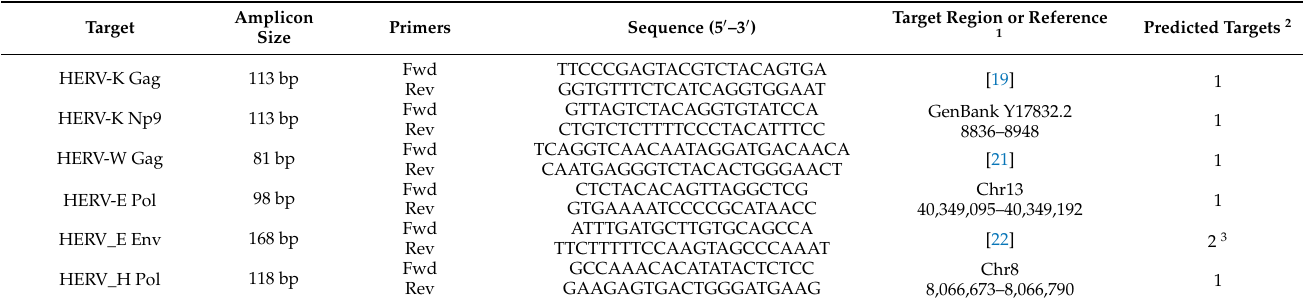
Table 1. Details of human endogenous retrovirus (HERV) primers and genomic regions